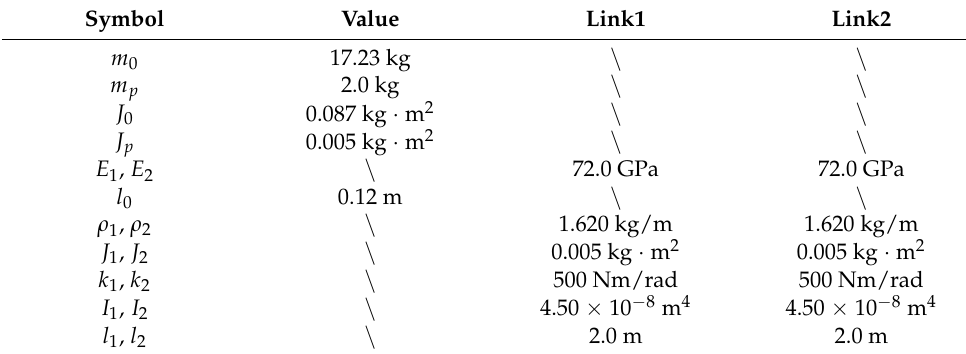
Table 2. The values of system parameters.